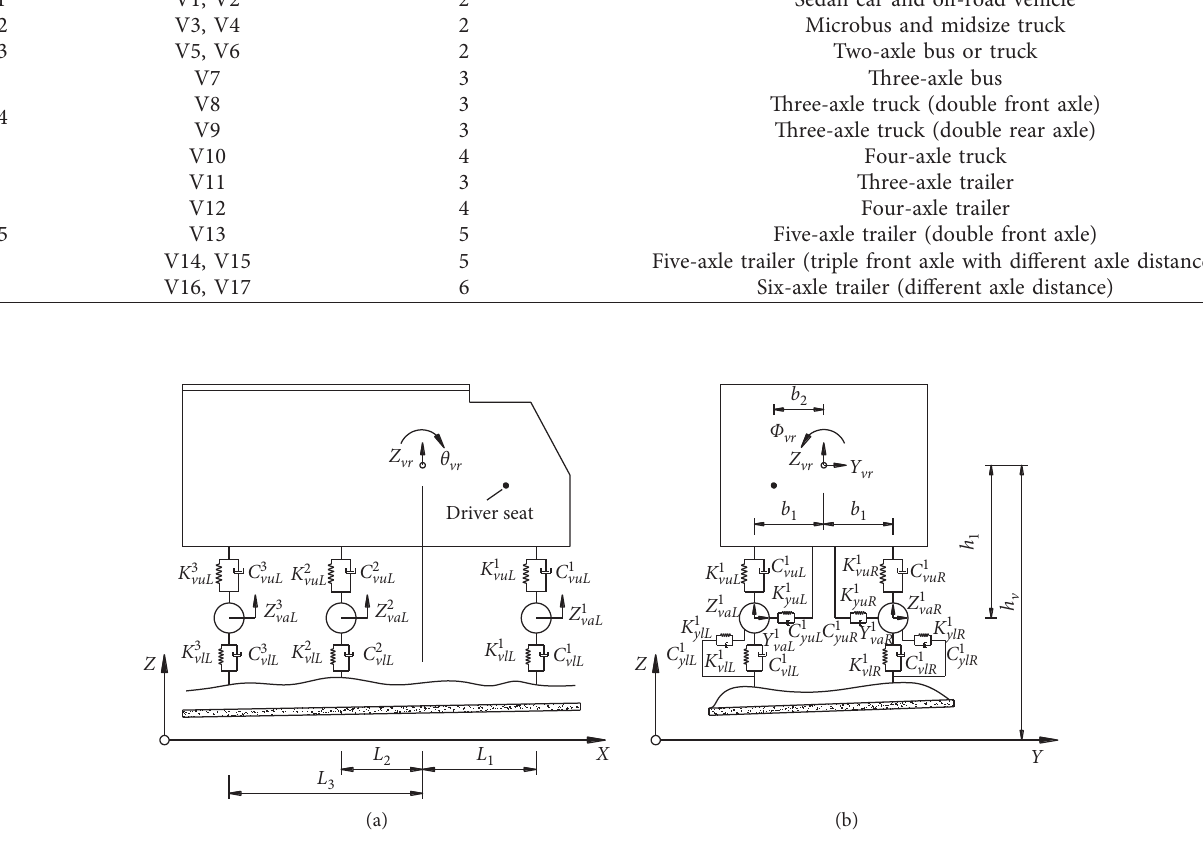
Figure 1: Dynamic analysis vehicle model of three-axle vehicle (double rear axle)